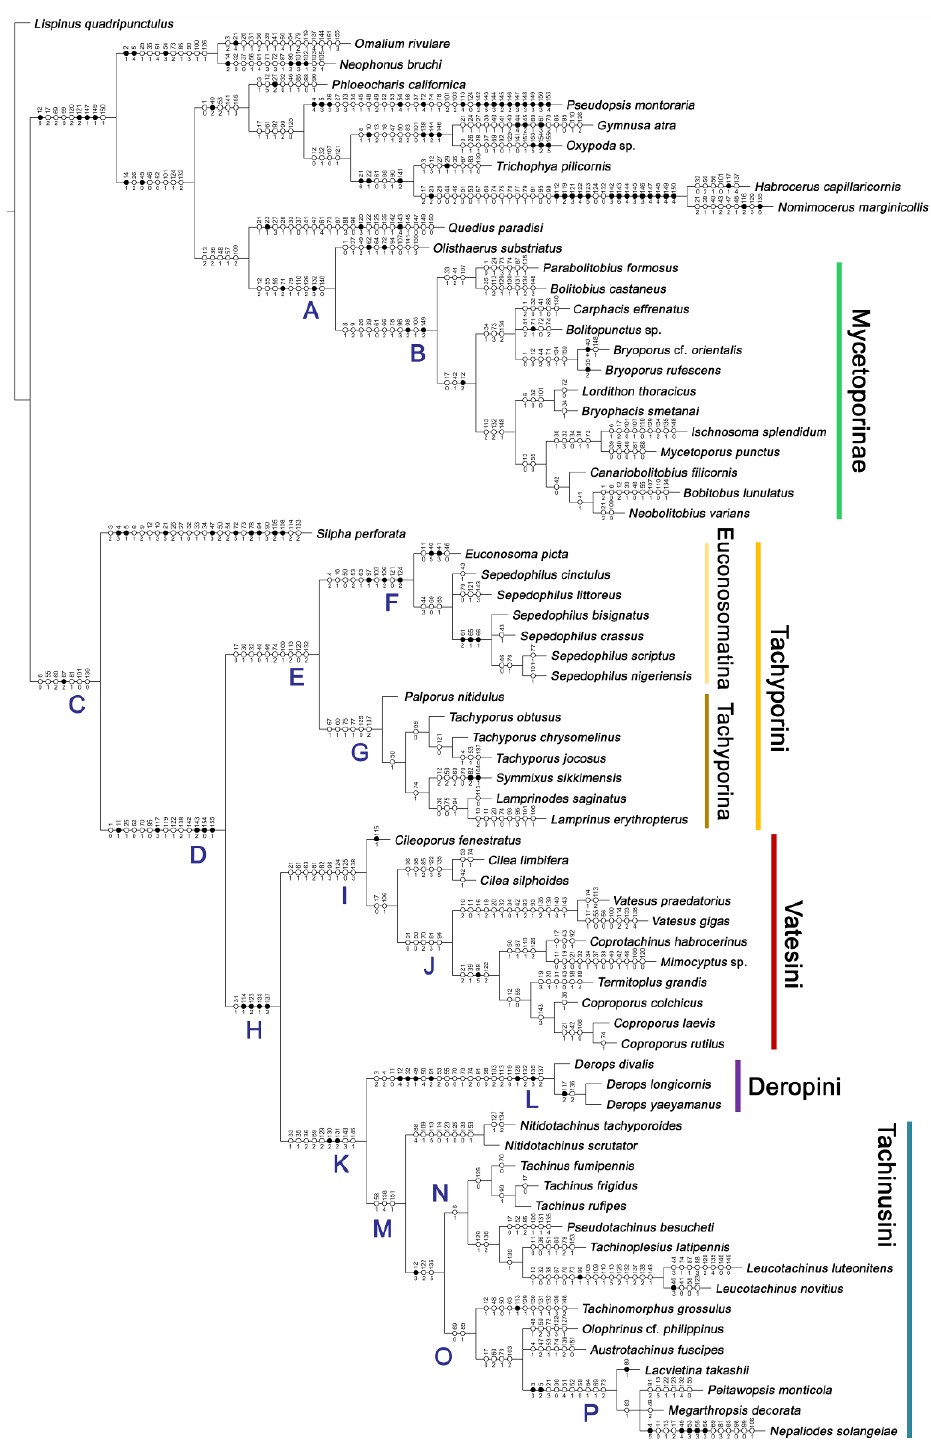
Figure 4. Results of the parsimony analysis of the phylogenetic relationships within Tachyporinae (strict consensus tree of the three obtained trees), with unambiguously optimized character changes plotted along the internodes. Black circles indicate unique character changes (unique synapomorphies), whereas white circles indicate parallelisms or reversals (homoplasious synapomorphies). Character numbers are given above circles, while character states are shown below circles. Each taxon name shown here reflects my taxonomic changes. A series of clades are named and used in the main text. Higher-resolution figure can be viewed at the figshare repository (https://doi.org/10.6084/m9.figshare.14179529; accessed on 9 April